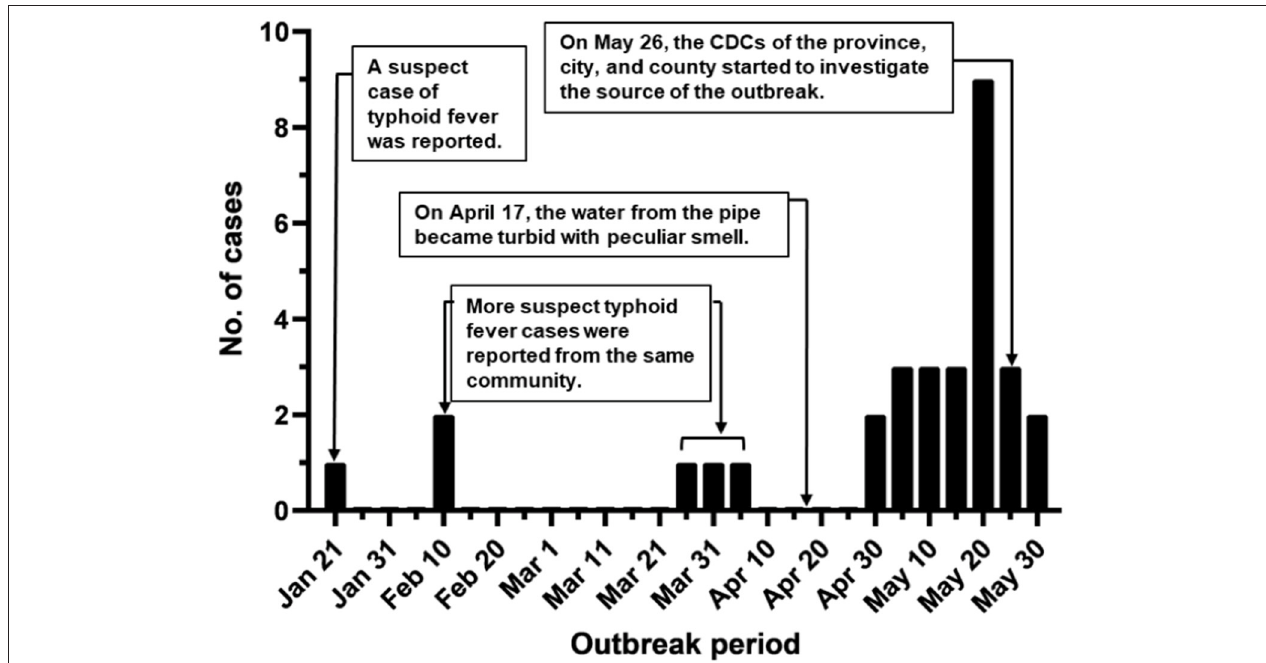
FIGURE 1 | Outbreak period of typhoid fever. Typhoid cases were documented during the outbreak in Lanling, China, in